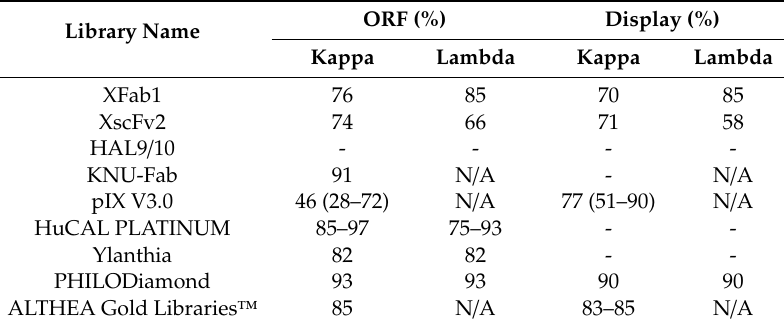
Table 2. Quality of the phage display antibody